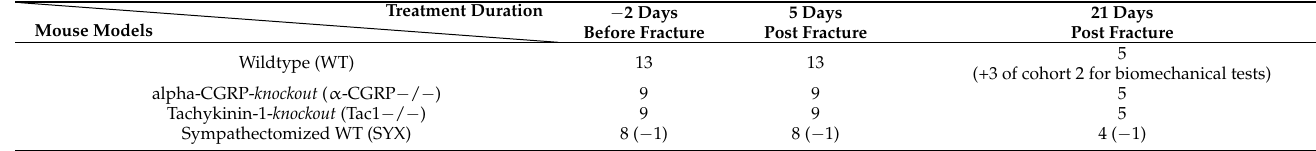
Table 4. Overview of the animal cohorts and